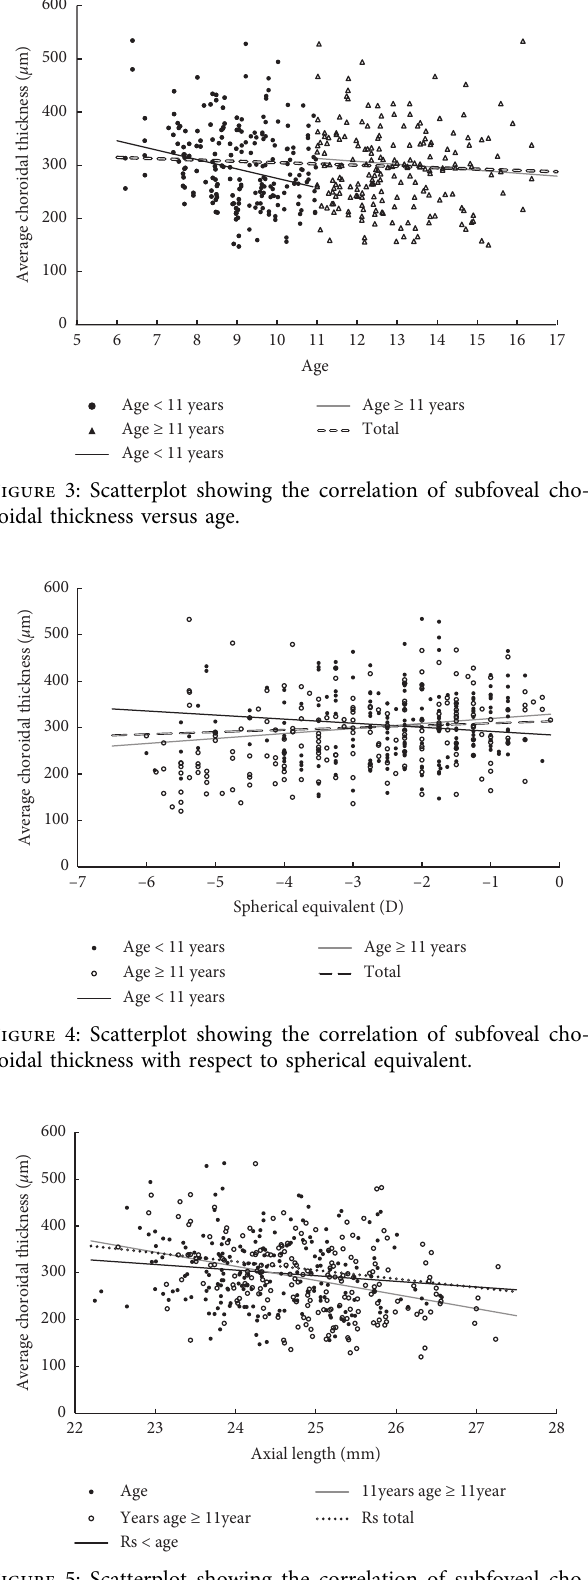
Figure 5: Scatterplot showing the correlation of subfoveal cho- roidal thickness (ChT) versus axial length. Children aged l < 11 years displayed a slower decrease in subfoveal ChT than children aged ≥ 11 years per mm of increase in axial